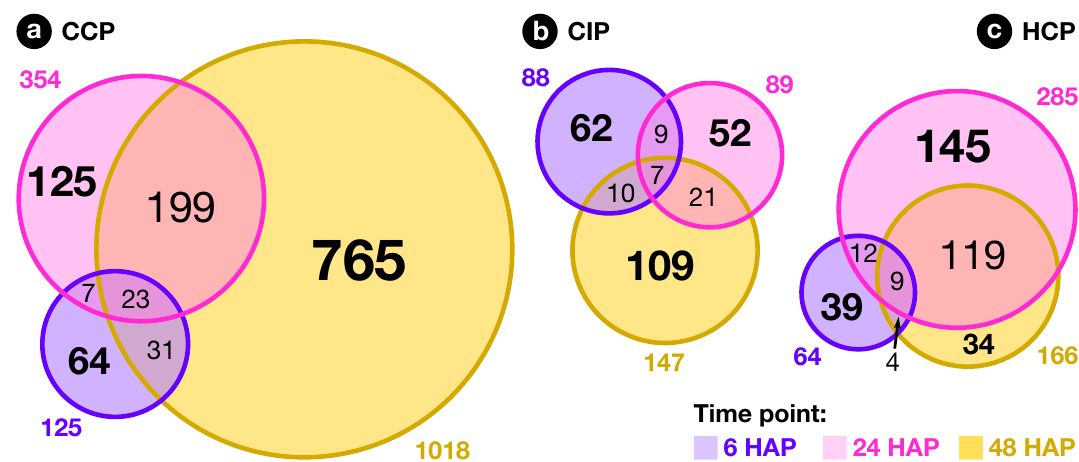
Figure 5. Overlap between time points. Venn diagrams showing the overlap between lists of genes modulated 6, 24 and 48 HAP after CCP, CIP, and